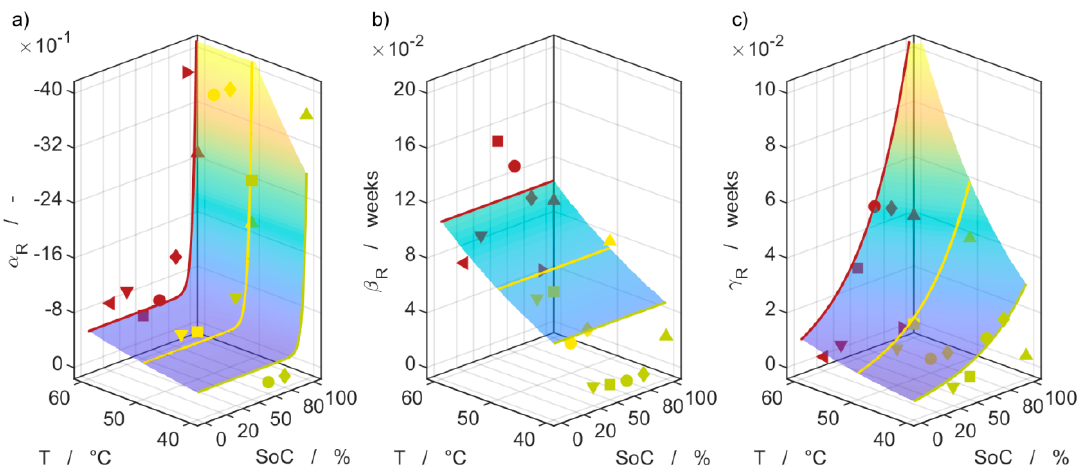
Figure 10. Comparison of the fit coefficients obtained from the R pol aging 2D and 4D fits. The markers indicate the results of the individual 2D fits with constant ( a ) α R , ( b ) β R , and ( c ) γ R . The colored lines represent the characteristic SoC dependency of the overall 4D fit evaluated at the three temperatures. The color shaded plane shows the SoC and Arrhenius temperature dependency of the 4D fit, and the markers are same as in Figure 8.